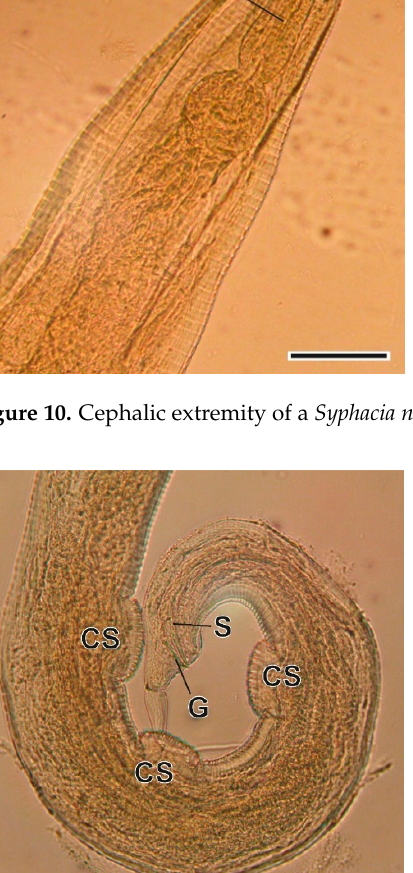
Table 5. Selected characteristics of the five most prevalent helminth species by host sex and age. CI—confidence interval, SE—standard error.